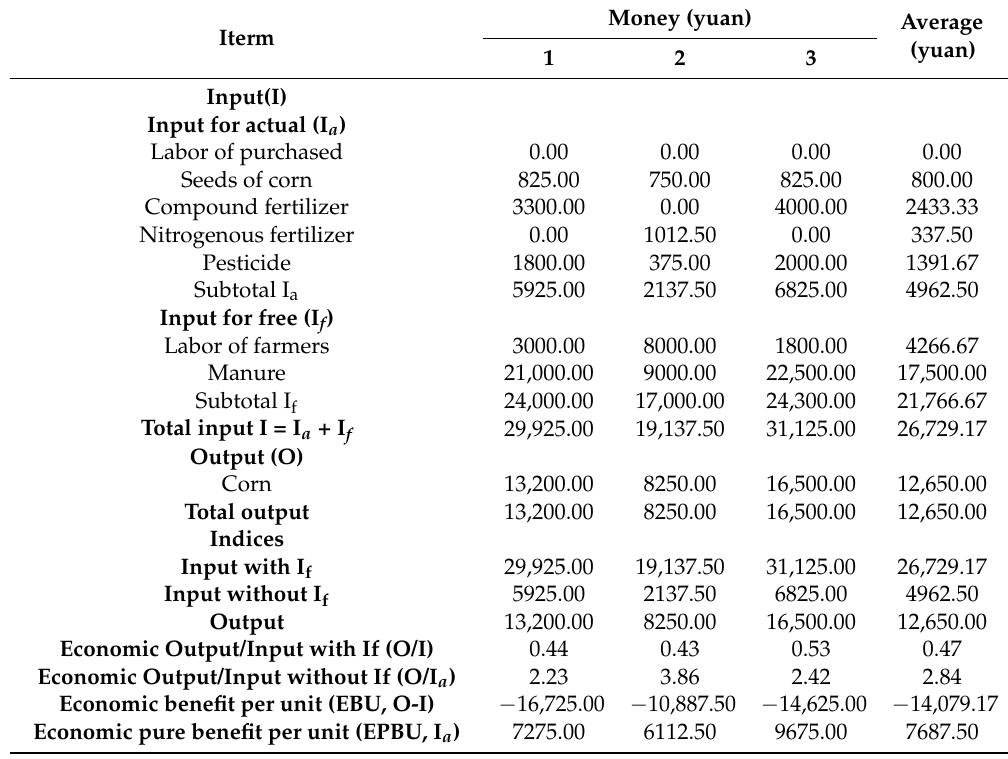
Table A2. Economical raw amounts of the CP in 2017